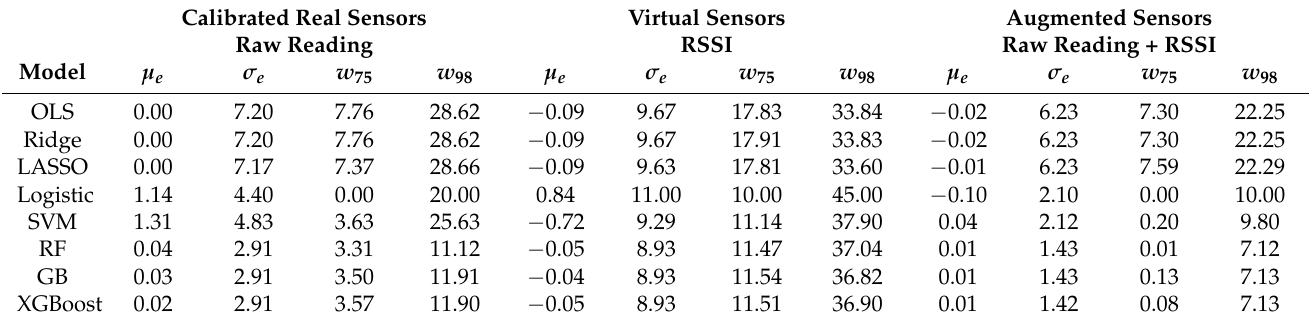
Table 3. Performances of analysed ML models for the test set. µ e is the mean estimation error, σ e the root mean square estimation error, w 75 and w 98 are the width of the VWC intervals containing, respectively, 75% and 98% of the estimation errors. The first set of columns presents the performances of the model versions grounded on raw readings only (i.e., the calibrated real sensors). The second set of columns presents the performances of the model versions relying on RSSIs only (i.e., the virtual sensors). Finally, the last set of columns presents the performances of the model versions accounting for both the raw readings and RSSIs (i.e., the augmented